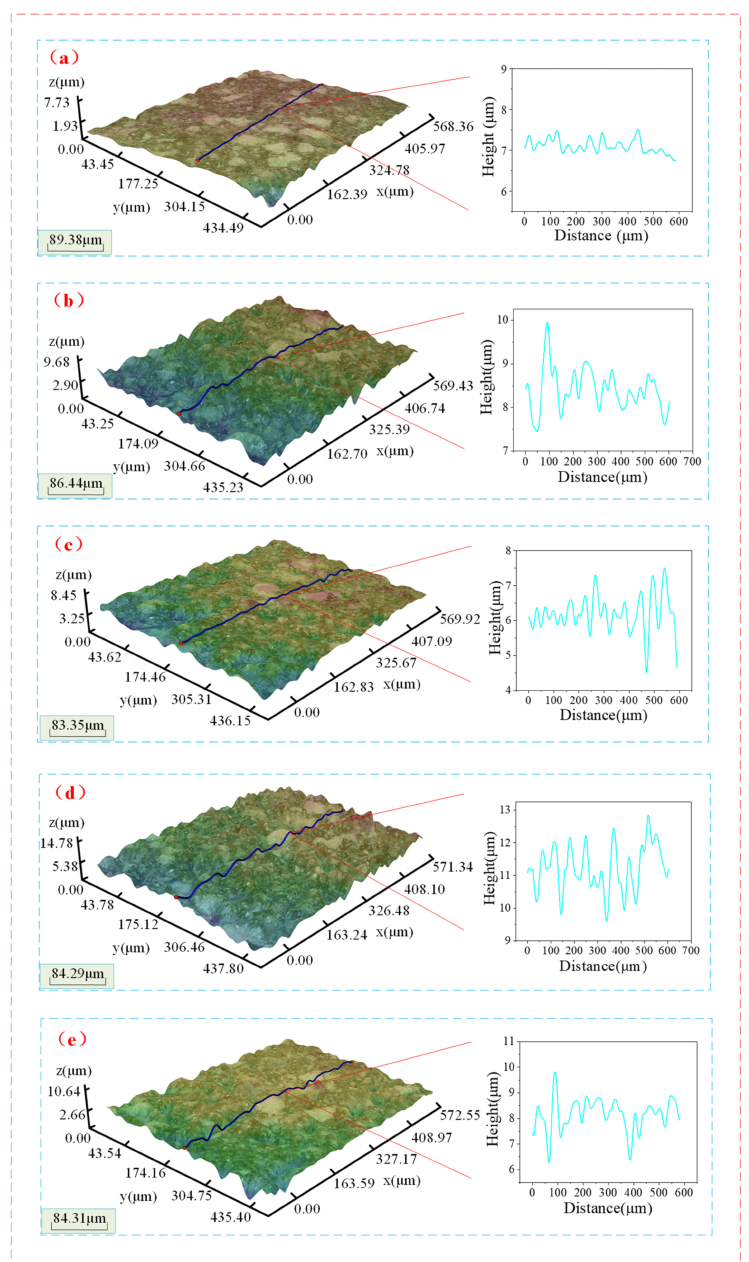
Figure 4. The surface morphology of some samples after dressing FAP by abrasive jet system: ( a ) the surface of the blunt FAP; ( b ) Experiment No. 1 on the surface of FAP; ( c ) Experiment No. 4 on the surface of FAP; ( d ) Experiment No. 8 on the surface of FAP; ( e ) Experiment No. 15 on the surface of